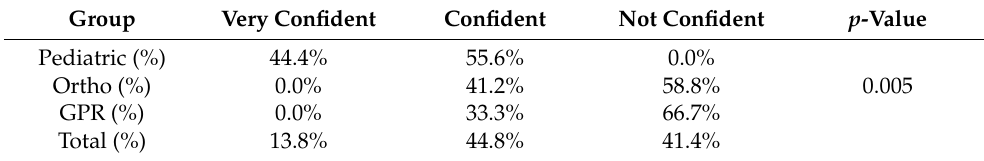
Table 1. Association between the line of specialty and level of confidence in identifying MIH. Group